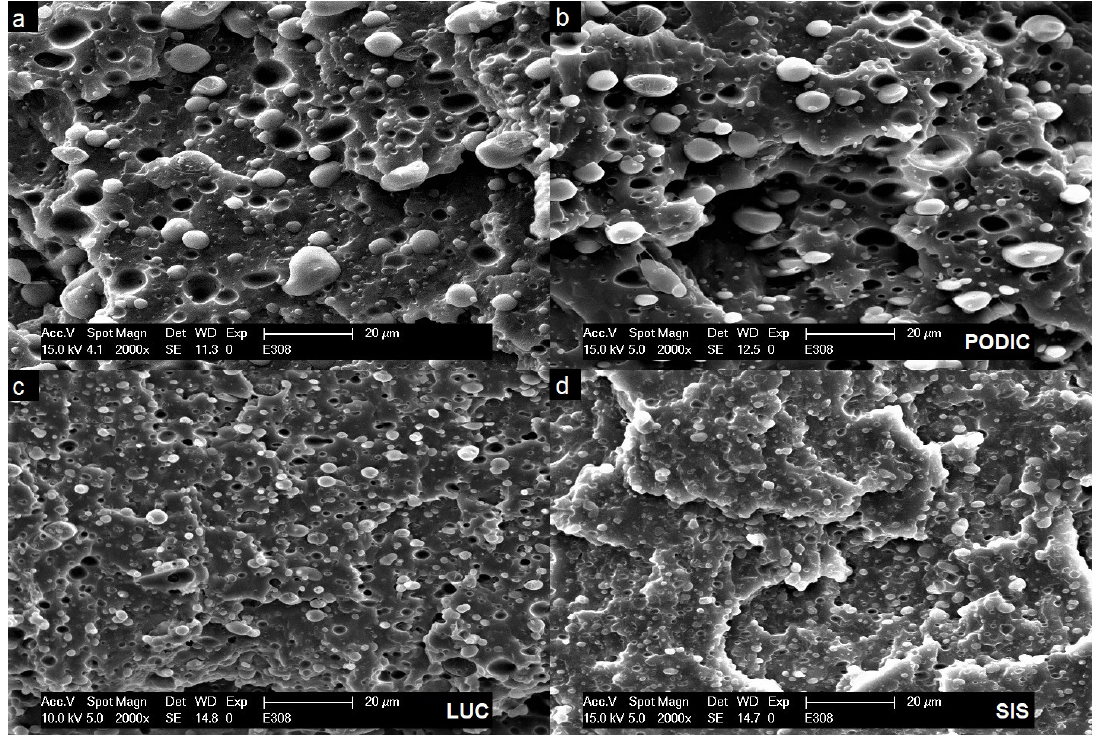
Figure 10. SEM micrographs of PP–PS 75:25 blends: uncompatibilized ( a ), PODIC ( b ), LUC ( c ), SIS ( d